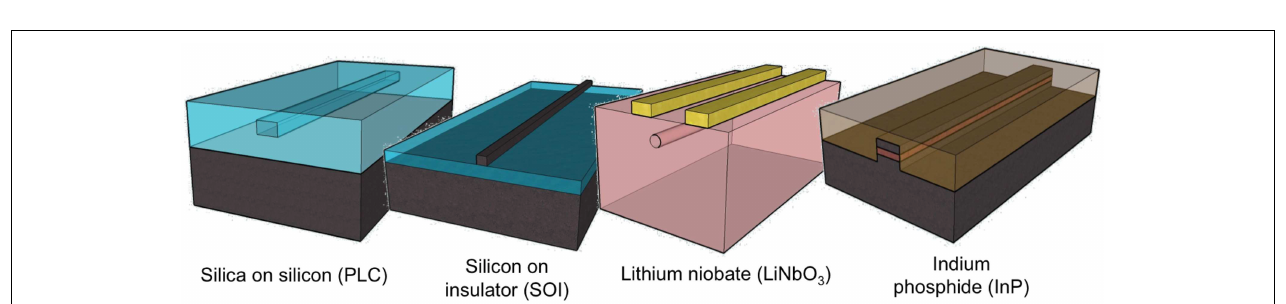
FIGURE 4 | Popular PIC material systems. The second from the left is a silicon wire waveguide and is the focus of this article.